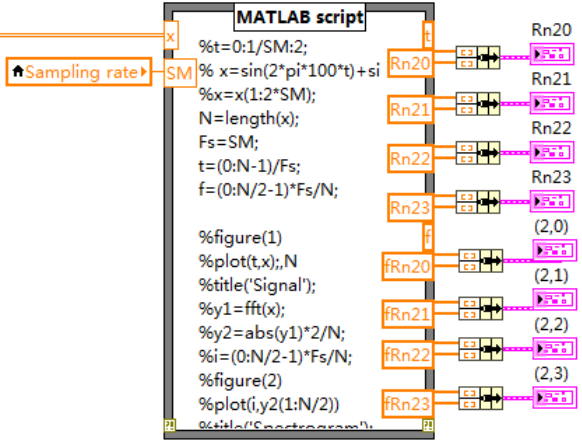
Figure 6. Improved wavelet packet algorithm.